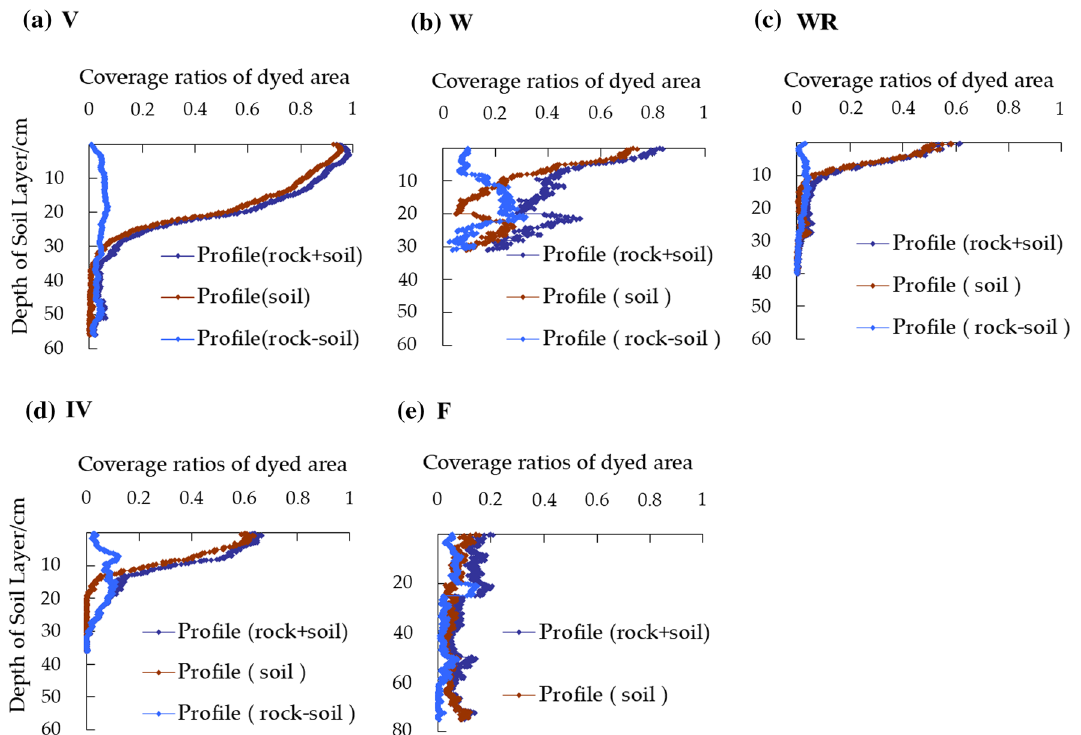
Fig. 6 Coverage ratios of dyed area in rock + soil, soil and rock–soil profiles. (V) V-type fissure, (W) W-type fissure, (WR) W + rocks-type fis- sure, (IV) inclined V-type fissure, (F) conduit fissure Table 2 Statistical characteristics of the dyed area ratio of profiles of different near-surface fissures